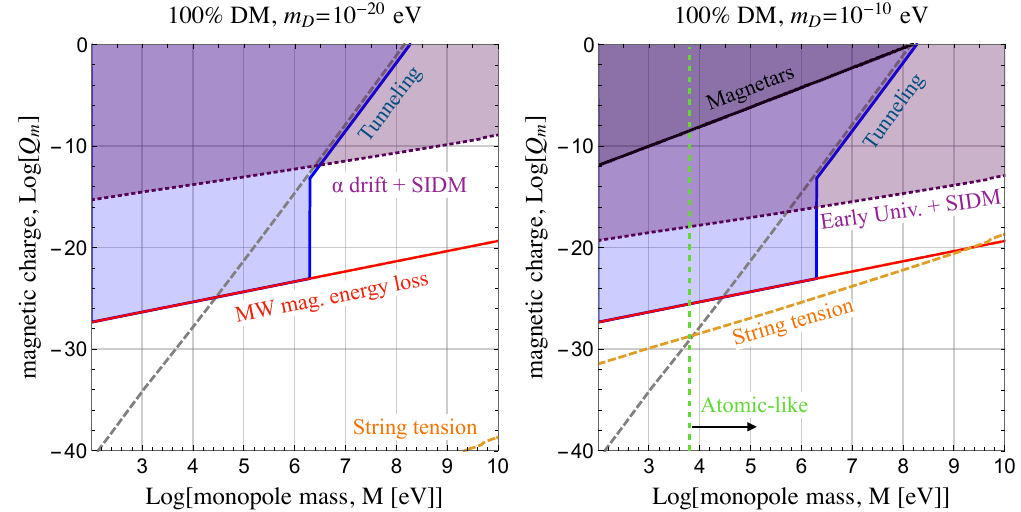
Figure 4 . Here we display bounds on the magnetic charge Q m as a function of magnetic monopole mass for two choices of dark photon mass, m = 10 − 20 eV (left) and m = 10 − 10 eV (right), D D assuming they comprise 100% of the halo dark matter. Parameter space above the red curve can lead to excessive loss of energy of the Milky Way’s magnetic field, as long as m − 1 , and in D (cid:29) ‘ this limit this bound is independent of m . The region shaded in blue leads to tunneling out of D the ground state on timescales less than the galactic magnetic dynamo, τ = 10 8 yr. In the dyn region below the orange dashed curve, internal string tension dominates over the external magnetic force and no magnetic energy can be extracted from the galaxy. Thus the excluded region comes from the maximum of these three curves. If instead the population of magnetic monopole-anti- monopole pairs are described by a plasma, then in the background Galactic magnetic field the magnetic monopoles are directly accelerated and the bound is instead given by the red line. For reference we also display the bounds from magnetar magnetic field lifetimes as derived in [7]. See text for discussion in section 5.2 regarding the model-dependent bounds coming from the early universe and α -drift. As shown in figure 3, magnetic monopole masses . 10 4 eV are non-atomic for m D = 10 − 10 eV. This boundary is shown by the green line in the right panel, and for the right panel does not enter for the mass range displayed. This boundary is discussed further in the main